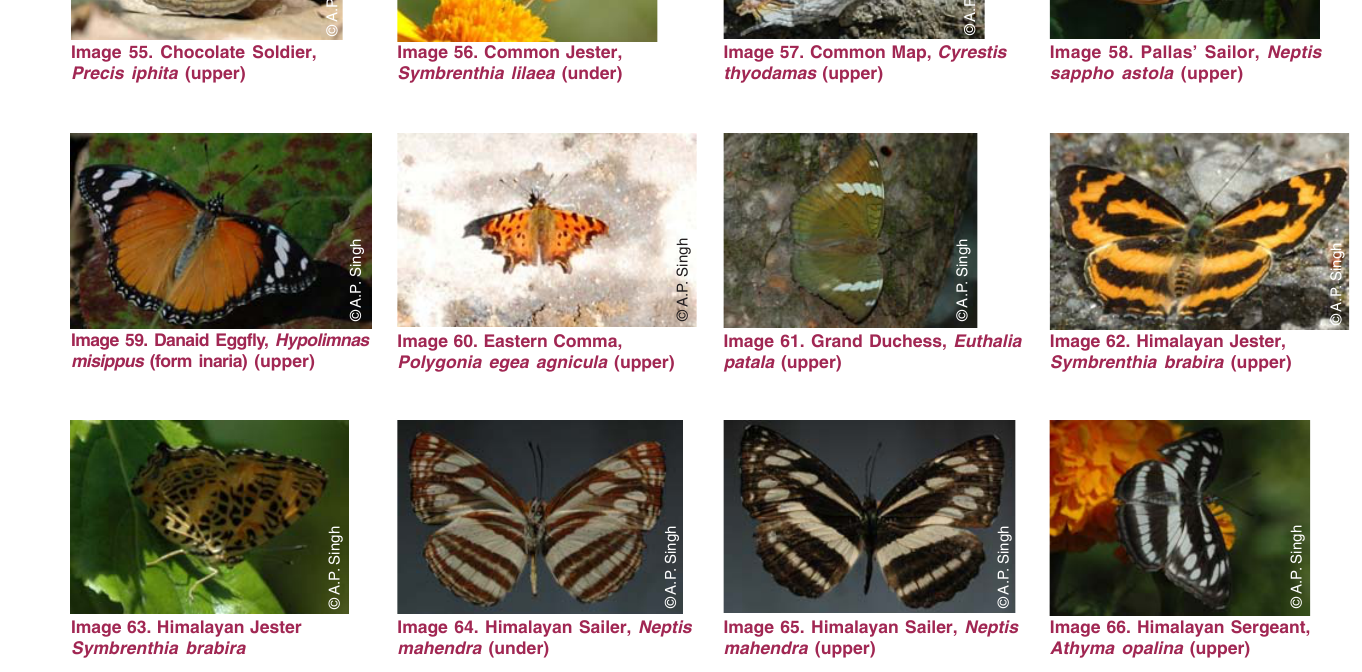
Image 64. Himalayan Sailer, Neptis mahendra (under)